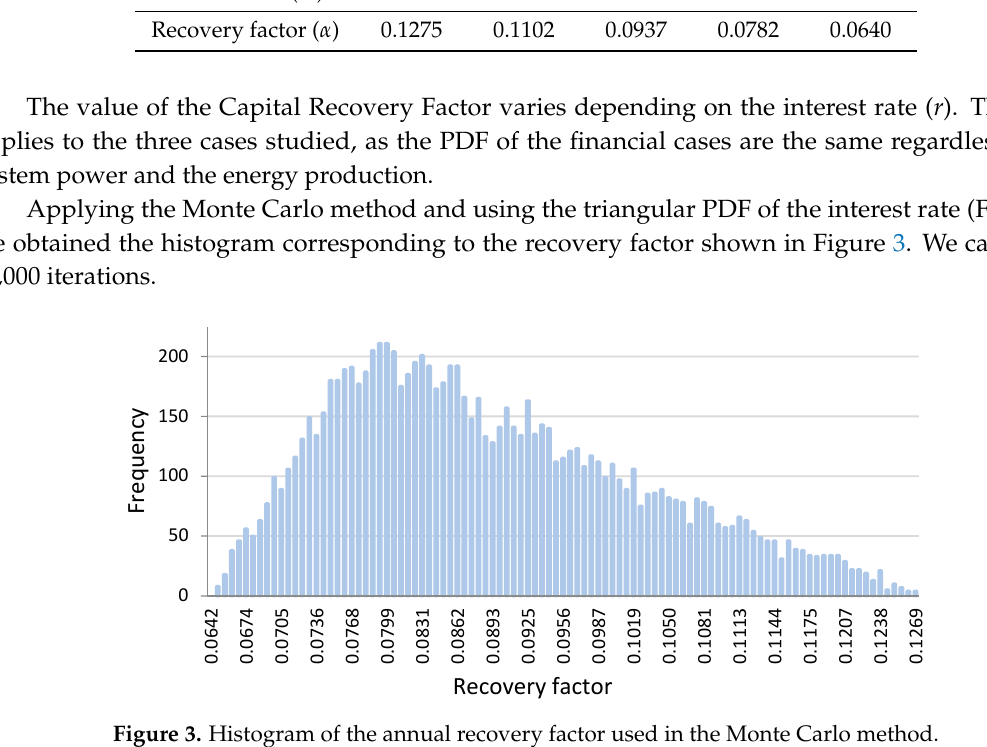
Table 2. PDFs used in the Monte Carlo calculation.